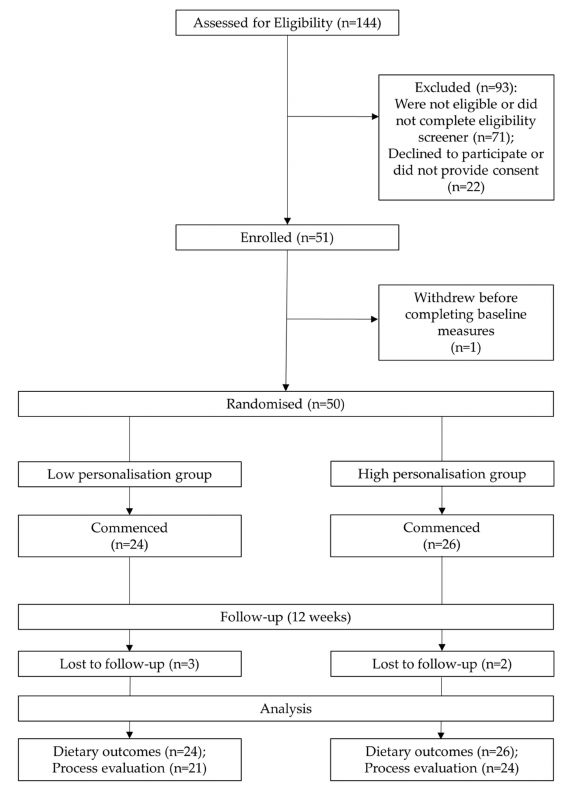
Figure 2. Flow diagram of study